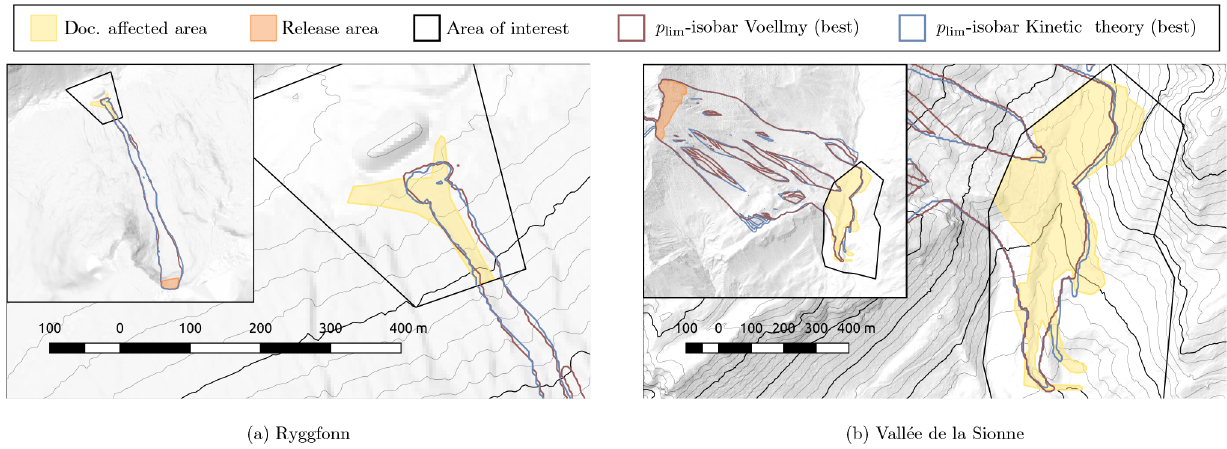
Figure 13. Outlines of the numerical simulations in comparison with the documented affected area for the avalanche event in Ryggfonn (a) and Vallée de la Sionne (b) . The red and blue lines show the p lim isobars for the simulation with the smallest residuals in affected area ( δA min ) for the Voellmy friction model and the new friction model, respectively. The yellow filled areas show the documented affected areas and the orange filled areas show the release areas. The evaluation of the affected area was limited to the area within the black polygons. In the figure showing the event in Rgf one can see that the avalanche (yellow area) stopped and spread apart about 50m before the dam. This results from a large snow deposit uphill of the dam. Because the digital elevation model does not take into account the snow height, numerical simulations show the same behavior of the avalanche with an offset of about 50m. The smallest residual is achieved by simulations with high friction, which leads to a stopping of the avalanche before reaching the dam and an untypical form.